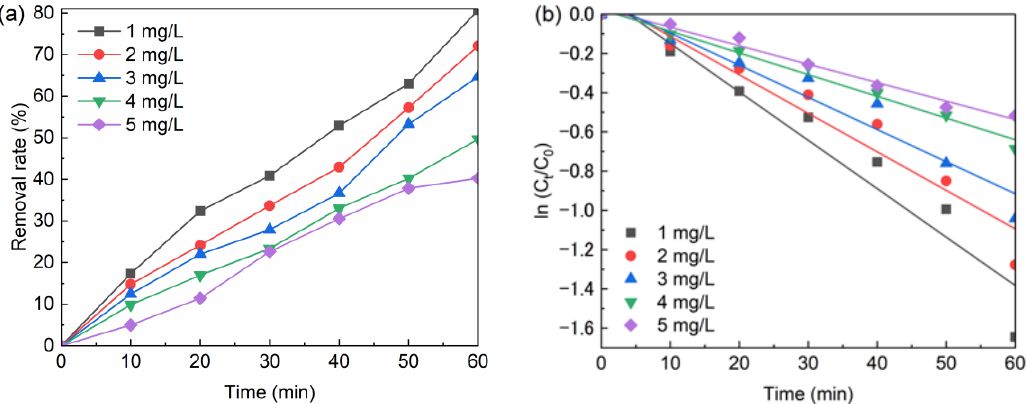
Figure 3. ( a ) The effect of BPA concentration on BPA removal; ( b ) The kinetic of BPA degradation by BPA concentration. Conditions: [nFe 3 O 4 ] = 0.1 g/L, T = 20 °C, pH = 6.8, [PS] = 0.2 mM, [BPA] = 1–5 mg/L. Table 3. The kinetic parameters of BPA degradation. BPA Initial Concentration Pseudo-First-Order Reaction Kinet- (mg/L)